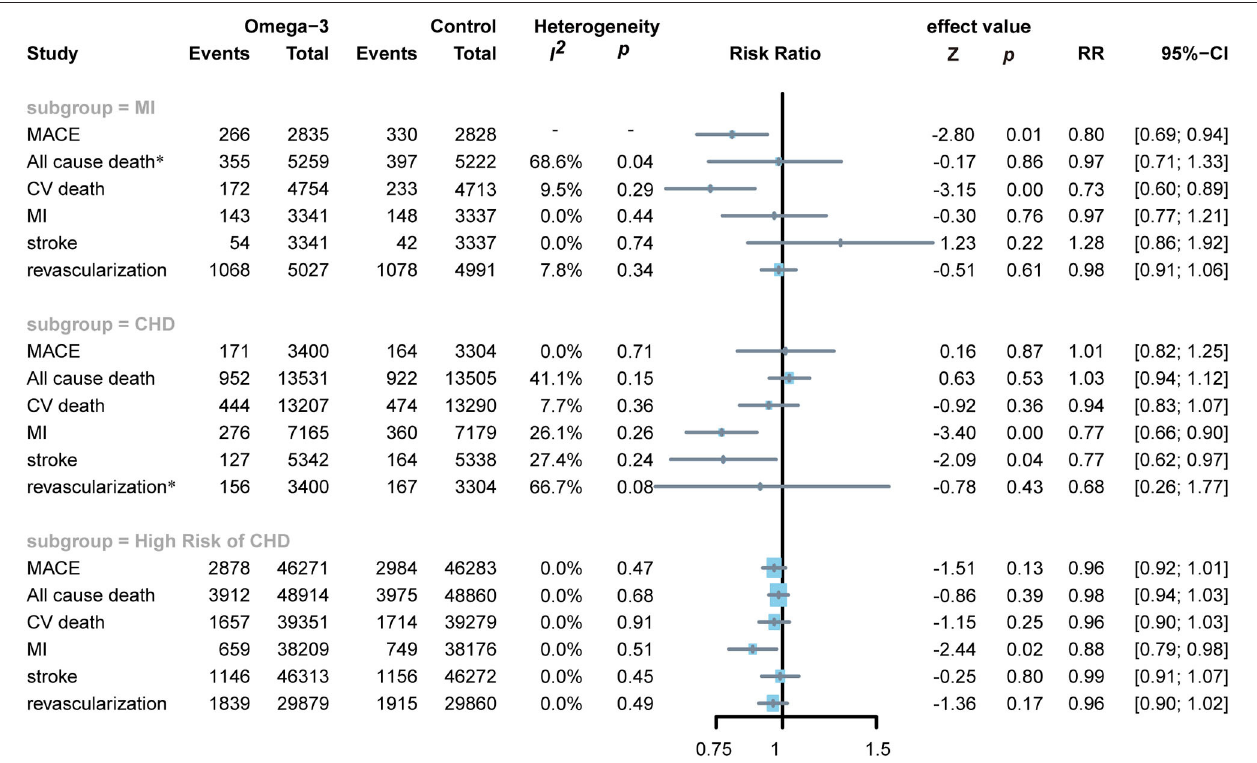
FIGURE 5 | Forest plot of subgroup of subjects with MI, CHD, and high risks of CHD. MI: myocardial infarction; CHD: coronary heart disease; MACEs, major adverse cardiovascular events; CV death, cardiovascular death. *Random-effects